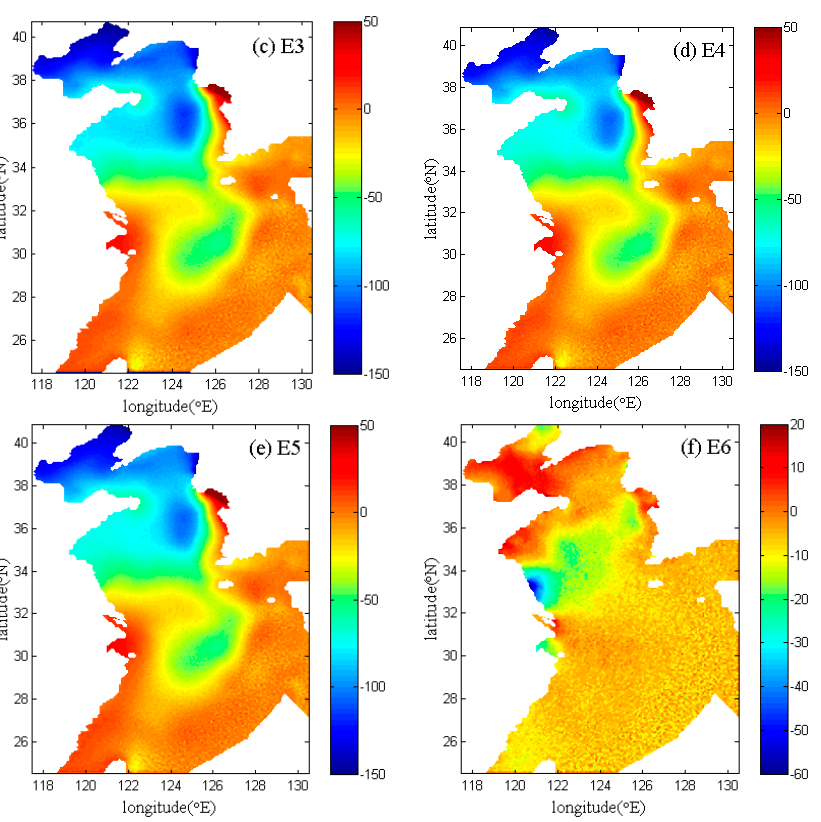
Figure 4. Spatial distributions of the simulated storm surge levels in ( a – f ) at 14:00 pm on 31 August 1970 during Typhoon 7008.